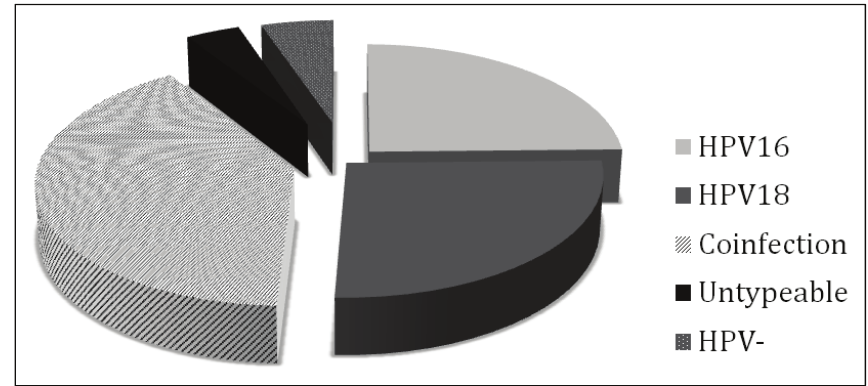
Figure 3. Distribution of HPV types 16 and 18 in cervical lesions. Seventy-three out of 77 samples tested were HPV positive, of which 31 were found co-infected with HPV16 and 18, 19 were positive for HPV 16 alone and 20 were positive for HPV18 alone. Three samples were HPV postive but the HPV type could not be